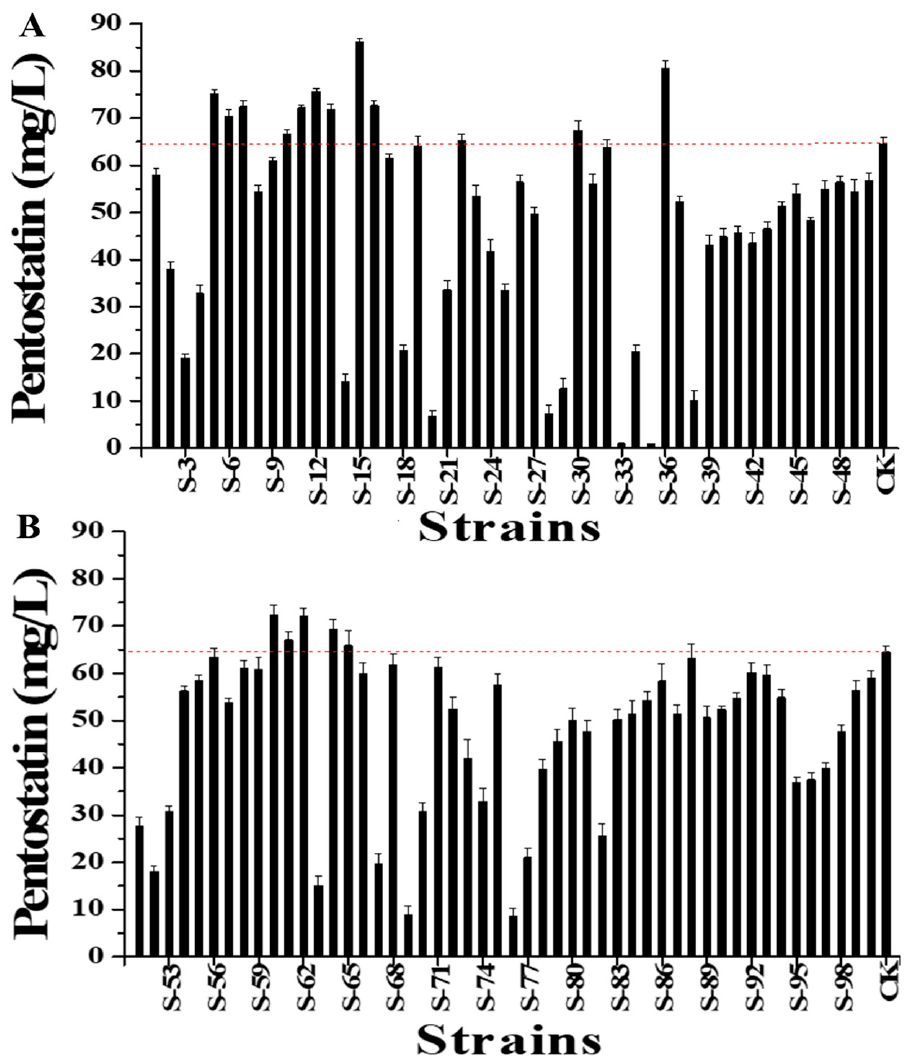
Figure 3. The pentostatin production of 100 mutants based on streptomycin screening. ( A ) The pentostatin production of mutants S-1 to S-50. ( B ) The pentostatin production of mutants S-51 to S-100. CK is the pentostatin production of control strain Actinomadura sp. ATCC 39365. The red dashed line is the dividing line based on the pentostatin yield of the negative control strain Actinomadura sp. ATCC 39365, and yields above the red dashed line are defined as high-yield mutants.